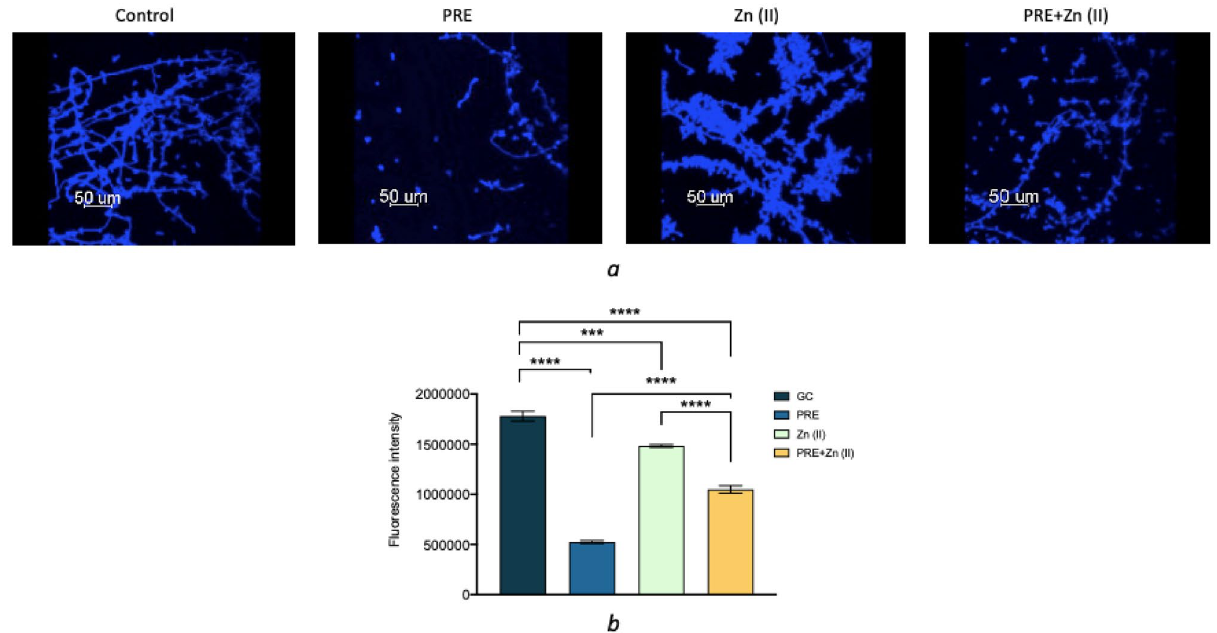
Figure 5. ( a ) CLSM imaging of PRE (4 mg/mL), Zn (II) (1.8 mg/mL) and PRE and Zn (II) combined (4 mg/ mL + 1.8 mg/mL) treated and untreated C. albicans biofilms, stained with Calcofluor-White to identify hyphal formation (for C. albicans cell walls in blue, scale bar = 50 µm). ( b ) The fluorescence intensities of Confocal Microscopy images. Significance indicated by *, where ***p < 0.001, and ****p < 0.0001. Data represented as mean ± SEM (n =